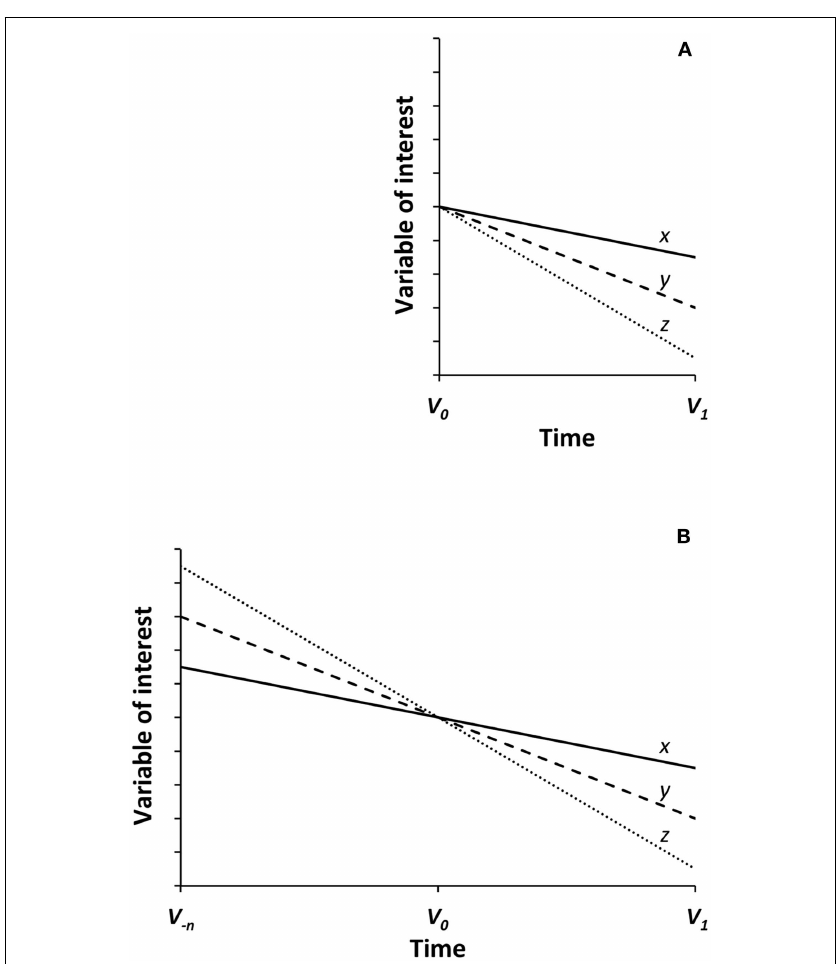
FIGURE 1 | Graphical description of the “horse-racing effect” in randomized clinical trials . V 0 and V 1 indicate the assessments conducted at the baseline and follow-up visits of the trial, respectively. V − n represents a hypothetical assessment conducted some time before V 0 . x , y , and z describe the trajectories of the variable of interest for the three randomization groups of the trial. Although the three groups ( x , y , and z ) seem to be correctly randomized and starting at a similar level at the baseline visit (A) , they are indeed characterized by pre-existing differences in their trajectories (B) . Such differences significantly affect the interpretation of trial